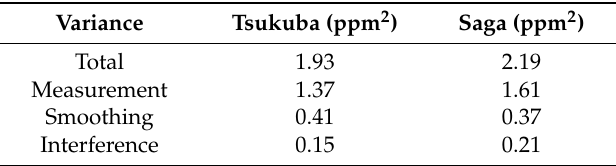
Table 5. Averaged values of variance components for two TCCON sites.